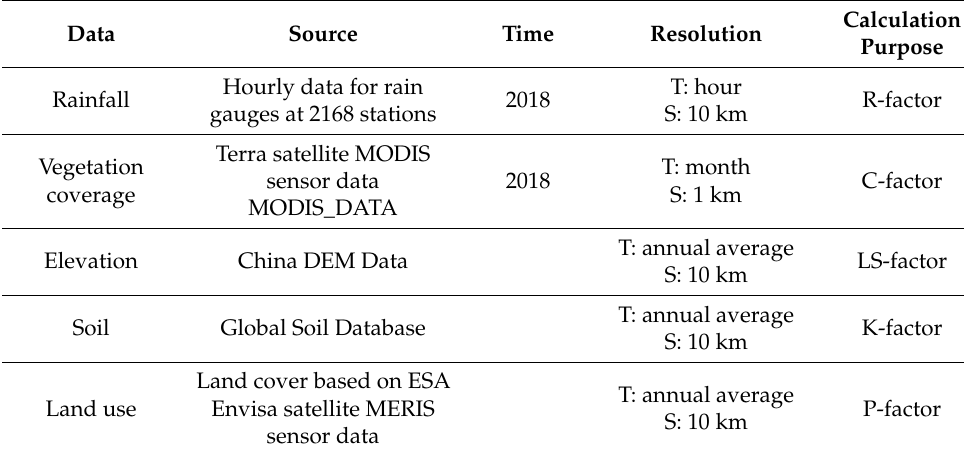
Table 1. Data source and resolution of each